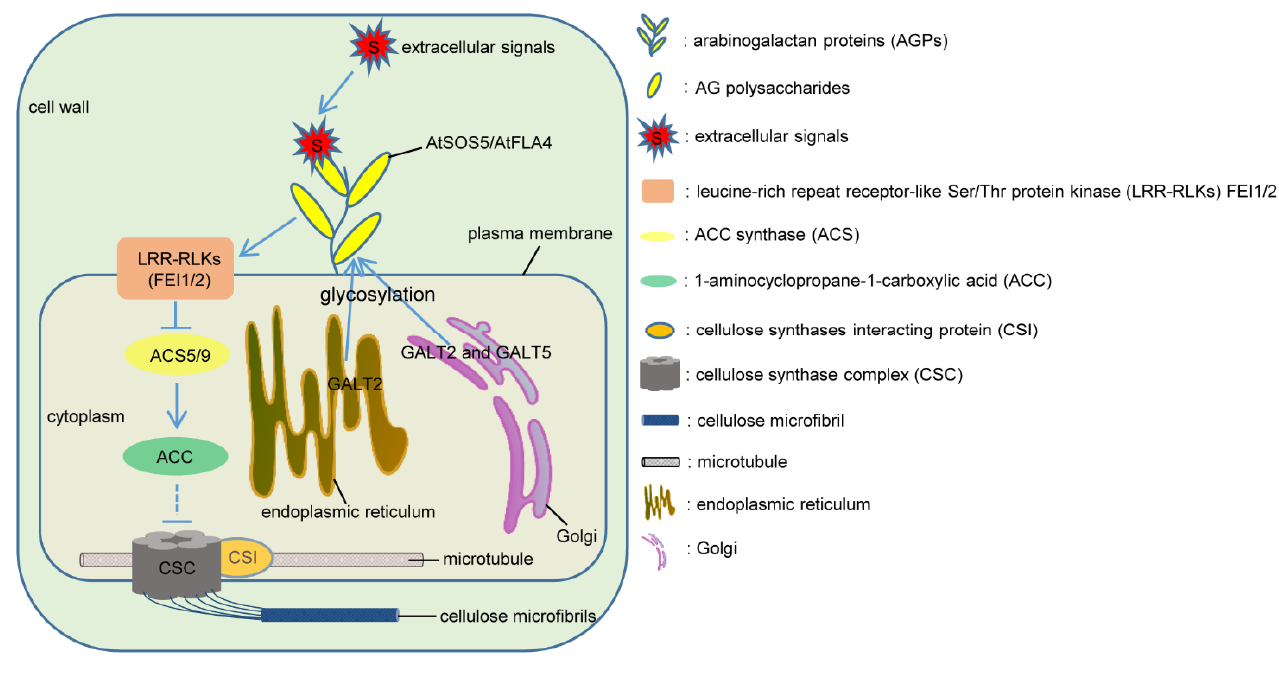
Figure 1. A hypothetical model of AGP involvement in cellulose synthesis via the 1-aminocyclopro- pane-1-carboxylic acid (ACC)-mediated pathway. AGPs may sense extracellular signals by carbo- hydrate moieties and transmit signals to some receptor kinases, thereby regulating cell wall for- mation by promoting cellulose synthesis through an ethylene-independent ACC pathway. Cellulose microfibrils are synthesized by cellulose synthase complexes (CSCs) that are present at the plasma membrane. GALT2 localized to the endoplasmic reticulum (ER) and the Golgi and GALT5 localized to Golgi vesicles function in AGP O -glycosylation [40]. AtSOS5/AtFLA4, FEI1, and FEI2 are local- ized to the plasma membrane [109,110]. The GALT2 GALT5/AtSOS5/FEI1 FEI2 pathway is repre- sented according to Basu et al.